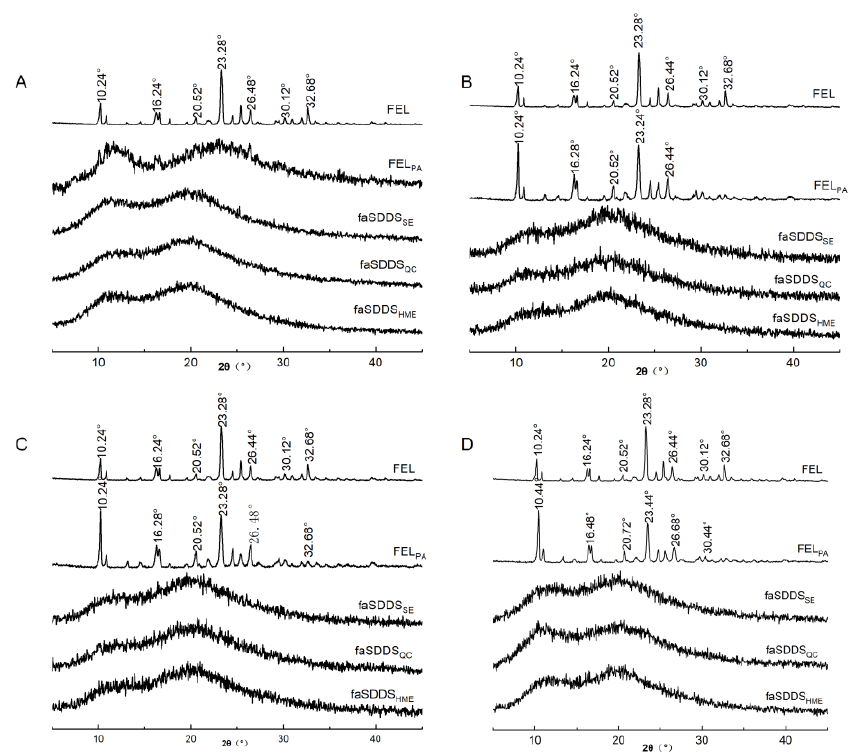
Figure 7. Stability of crystalline FEL, FEL PA , faSDDS SE , faSDDS QC and faSDDS HME by powder X-ray diffractogram after 0 month ( A ), 1 month ( B ), 3 months ( C ), and 4 months ( D ).